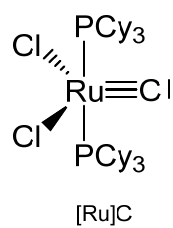
Figure 21. The [Ru]C core.